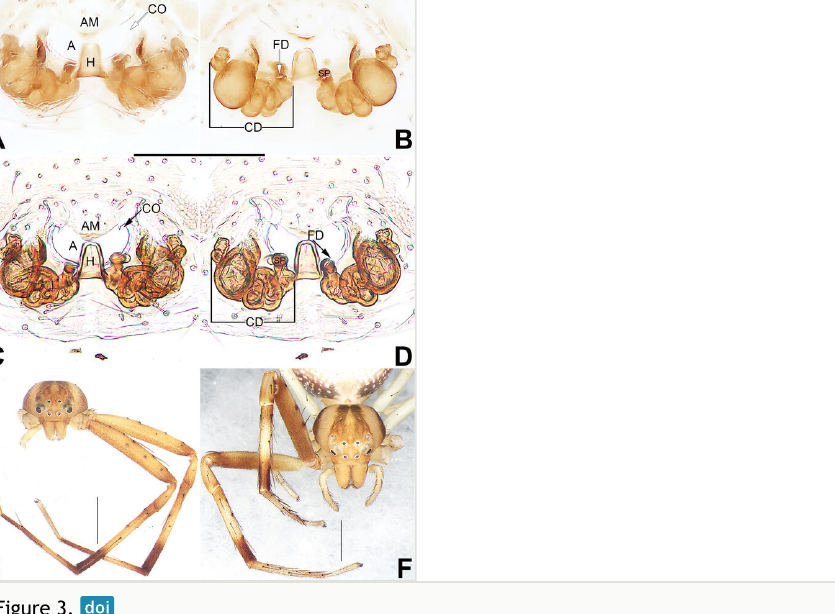
Figure 3. Synema guiyang sp. nov., female paratype and male holotype, epigyne ( A–D ), frontal views of prosoma ( E – F ). A – B Macerated epigyne, ventral and dorsal; C – D Epigyne, macerated and embedded in Arabic gum, ventral and dorsal; E Male; F Female. Abbreviations: A = atrium;